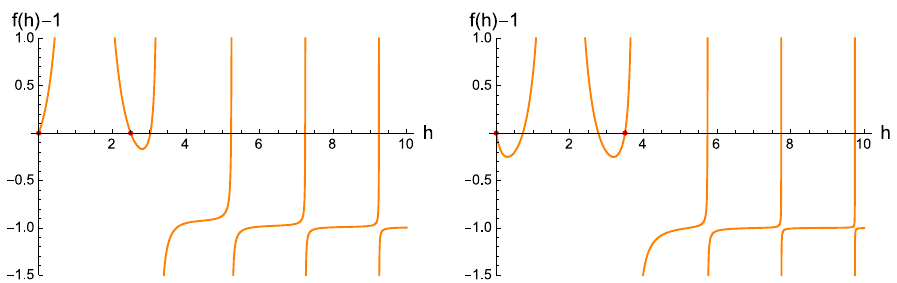
Figure 15 . Plots of f ( h ) (cid:0) 1 for d = 2 : 5 (left) and d = 3 : 5 (right) at g = g 0 ( d ). The zeros on the left panel correspond (from left to right) to h 0 (cid:0) , h 0+ , and h 1 to h 4 , while on the right panel this applies only to h > 0, as h = 0 is a new solution. The zeros at h = 0 and h = d are marked by a red